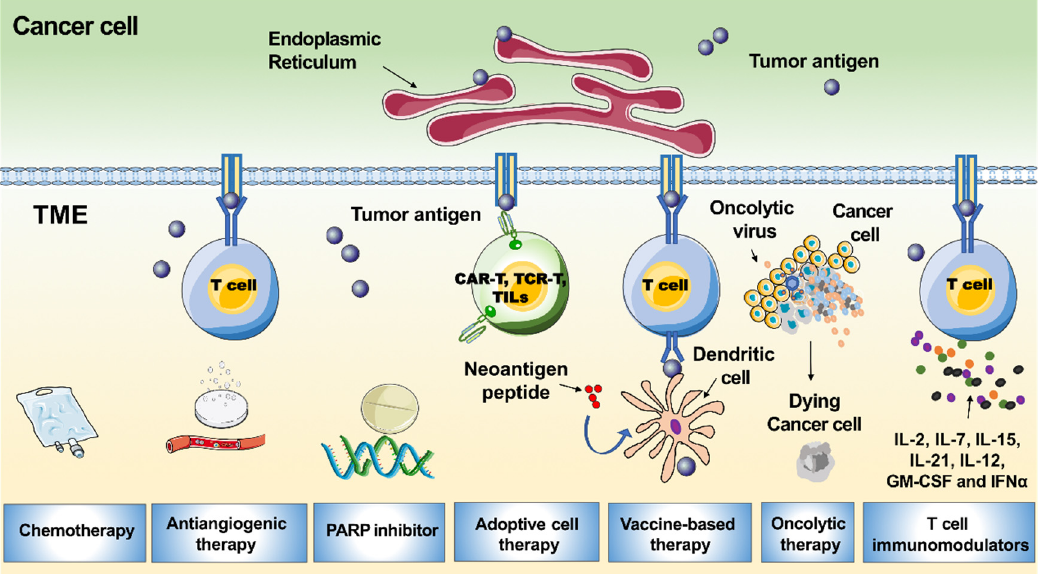
Figure 2. Mechanism of immunotherapy. Blocking the interaction between PD-1 and PD-L1 could reverse and/or prevent the exhaustion of tumour-specific T lymphocytes, promoting the surveillance and destruction of tumour cells. TME; tumour microenvironment.